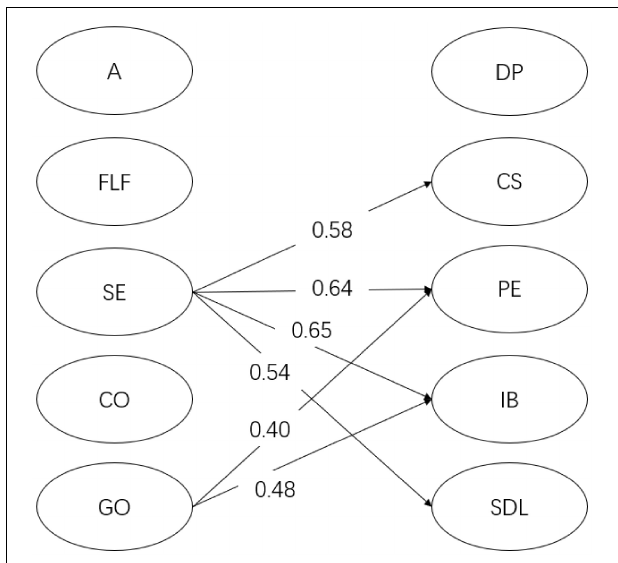
FIGURE 4 | The SEM model for year 3 students. Only significant relations are presented in the figure. DP, doing previews; CS, in-class communication self-efficacy; PE, positive experience of flipped classroom; IB, intentional behaviors; SDL, self-directed learning; A, autonomy; FLF, formative learning feedback; SE, English learning self-efficacy; CO, communication-oriented learning; GO, grammar/translation-oriented learning.